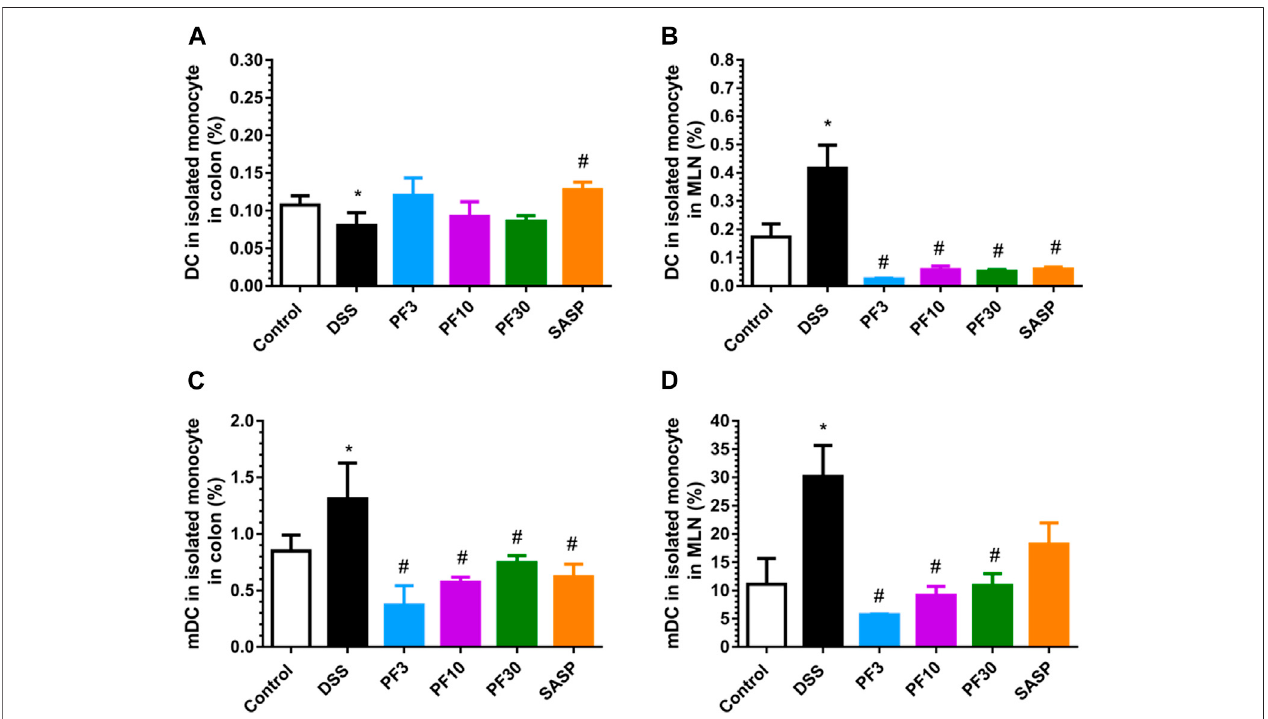
FIGURE5| PF-04447943amelioratedDSSinducedcolitissuppressingDC andtheir maturation. (A) PercentoftotalDCcells inisolatedmonocyte fromthe colon. (B) PercentoftotalDCcells inisolatedmonocyte from mesentericlymphnode (MLN). (C) Percent ofmatureDC cellsinisolatedmonocytefrom thecolon. ( D ) Percentof matureDCcellsinisolatedmonocytefromtheMLN.Dataarepresentedasmean ± standarderrormean(SEM)(n (cid:1) 5).Here,*** p < 0.001,** p < 0.01,* p < 0.05vs . control group and ### p < 0.001, ## p < 0.01, # p < 0.05 vs. DSS-treated